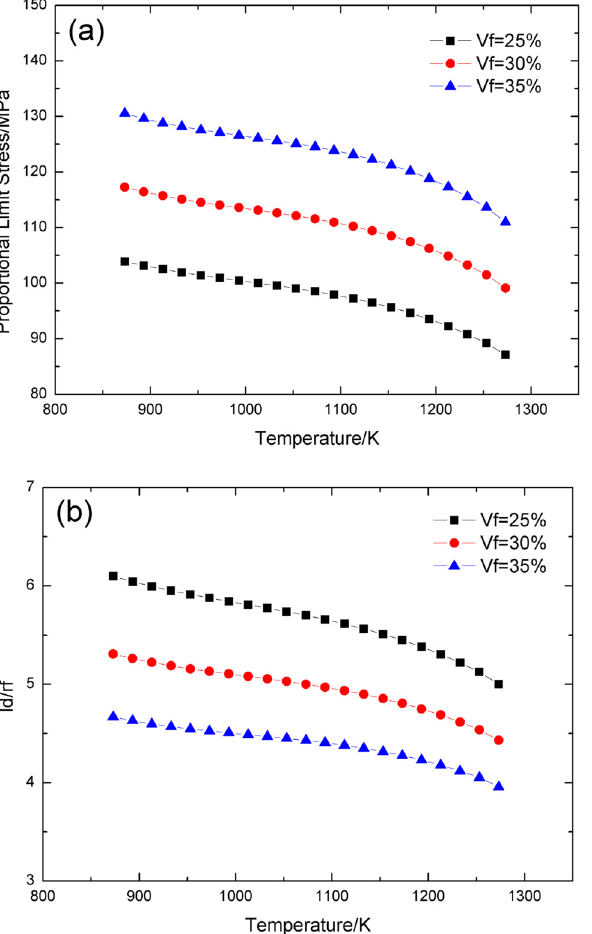
Figure 2: E ff ect of the interface shear stress on ( a ) the PLS versus temperature curves and ( b ) the fi ber/matrix interface debonding length versus temperature curves of SiC/SiC